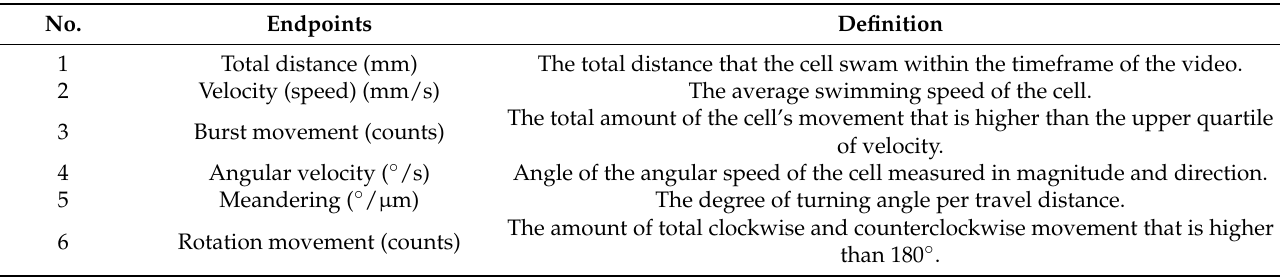
Table 1. Summary of all locomotor endpoints used in this